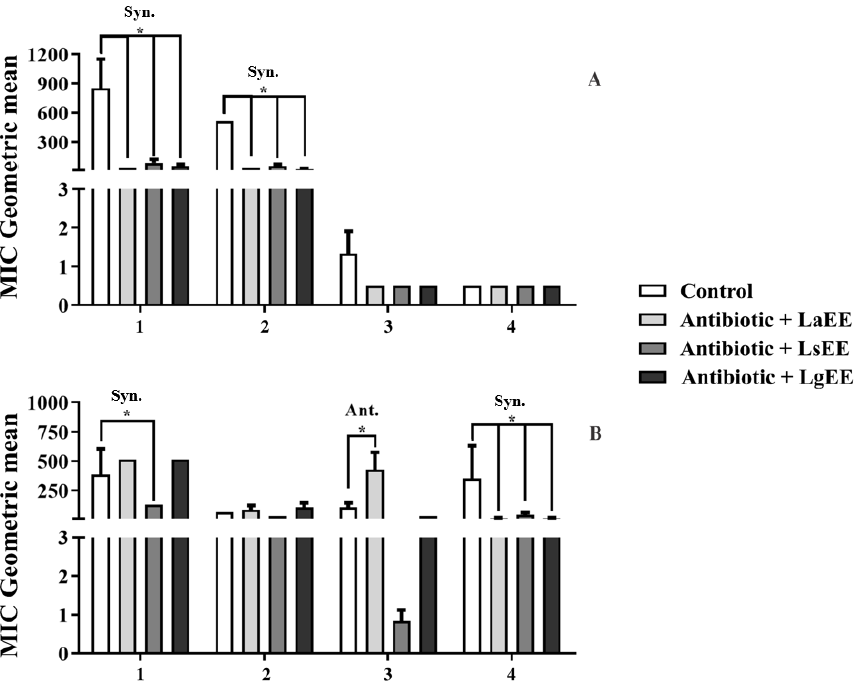
Figure 3. Effects of the ethanolic extracts of L. alba (LaEE), L. sidoides (LsEE), and L. gracilis (LgEE) on the antibiotic activity of amikacin (1), gentamicin (2), benzylpenicillin (3), and cephalothin (4) against Staphylococcus aureus Sa 358 ( A ) and Escherichia coli Ec 27 ( B ). Syn.: synergism; Ant.: antagonism; *: p < 0.05 (ANOVA and Bonferroni’s post -test).